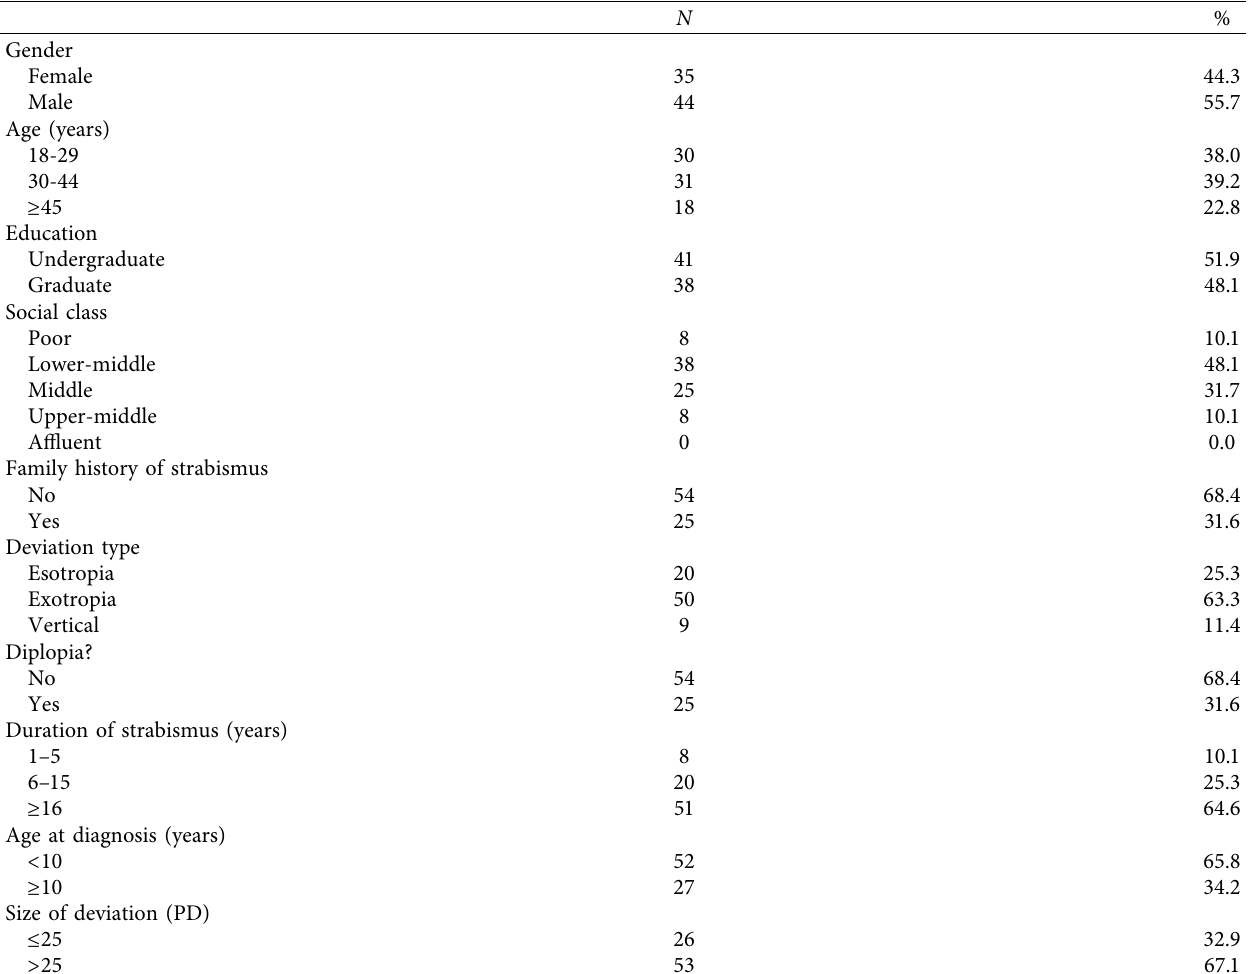
Table 1: Sociodemographic and clinical characteristics of the patients ( n �